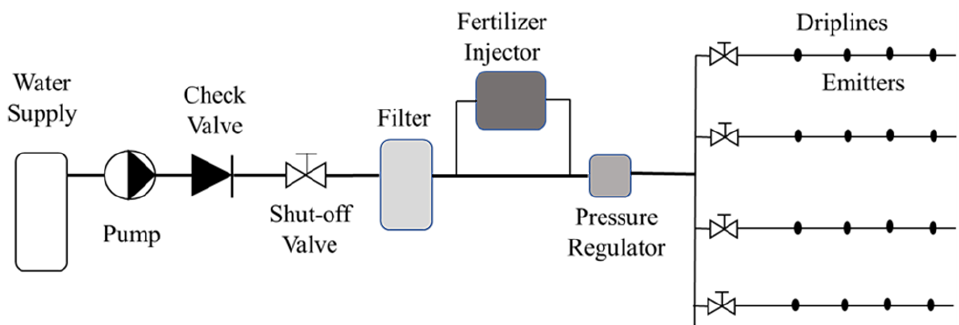
Figure 2. A simplified drip irrigation system schematic